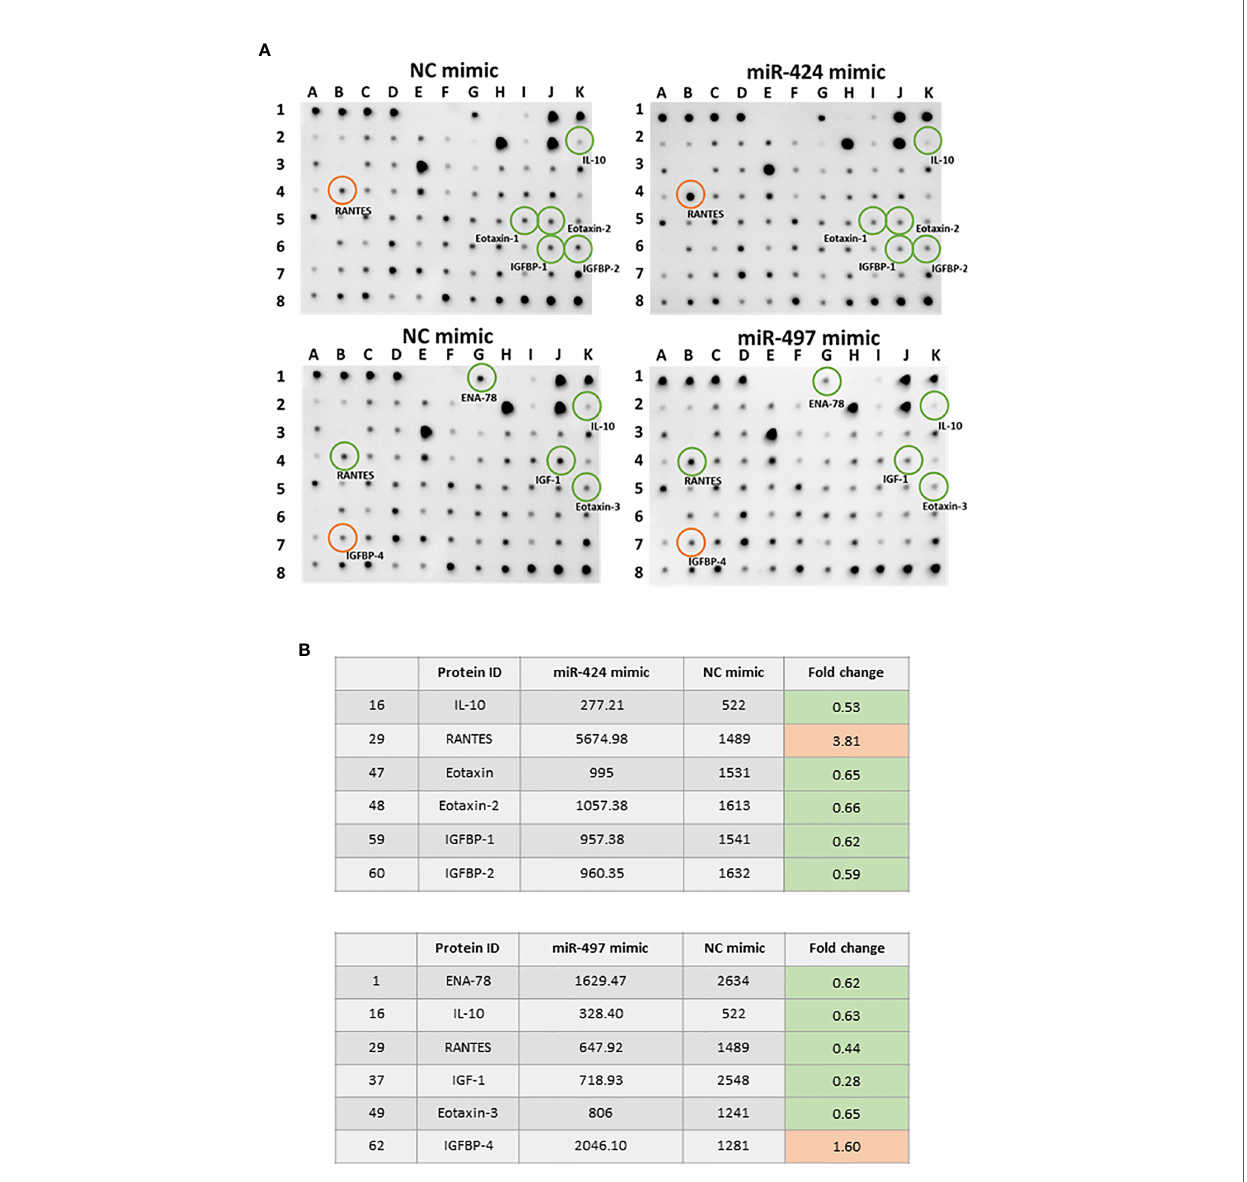
FIGURE 5 | Cytokine expression alteration caused by gain of miR-424 and miR-497 function for 48 h in RASF. (A) Image result of cytokine array from the supernatant of RASF transfected with 10 nM miR-424 or miR-497 mimic for 48 h. Red circle: Elevated expression. Green circle: Reduced expression. (B) All differentially expressed cytokines in miR-424 and miR-497 with fold change ≤ 0.67 or fold change ≥ 1.5. RASF cells isolated from synovial tissue of 4 RA patients were transfected with miR-424 and miR-497 mimics. Triplicates were used for each transfection